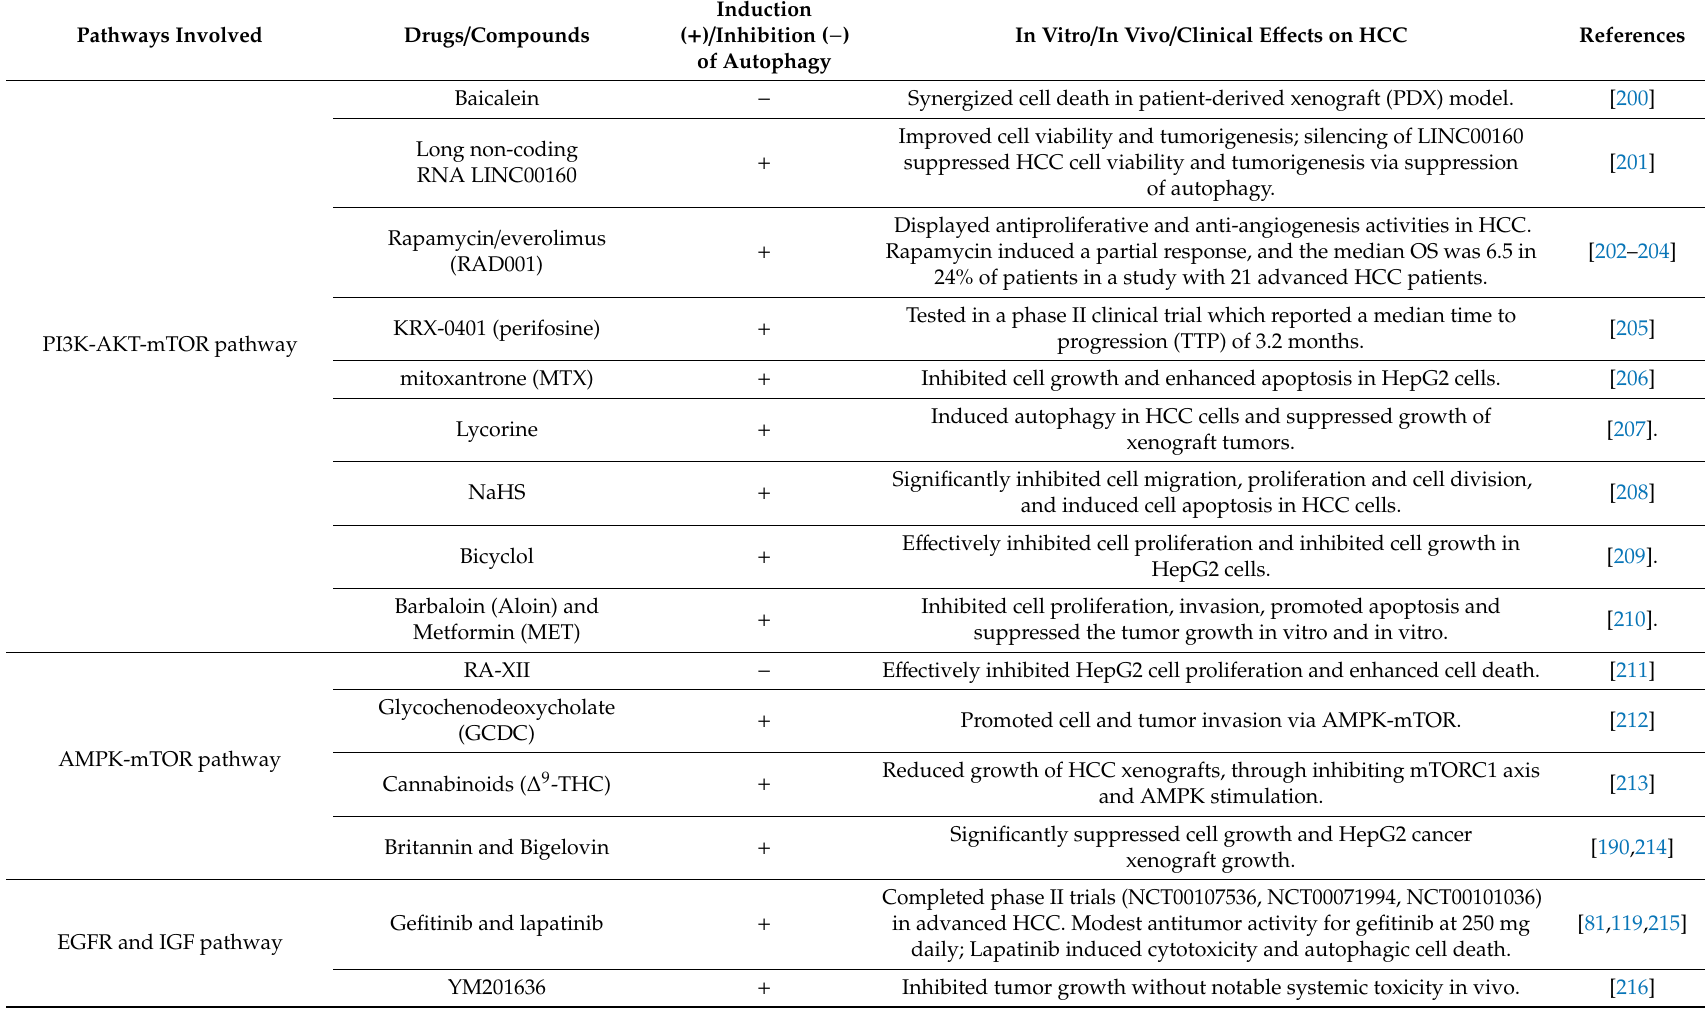
Table 1. Targeting autophagy as an anti-cancer strategy for liver cancer treatment via signaling